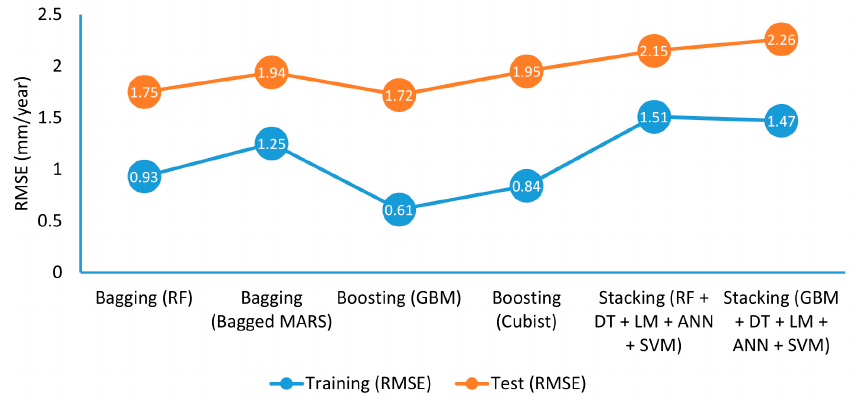
Figure 7. The comparison of ensemble models by the average RMSE (mm/year)